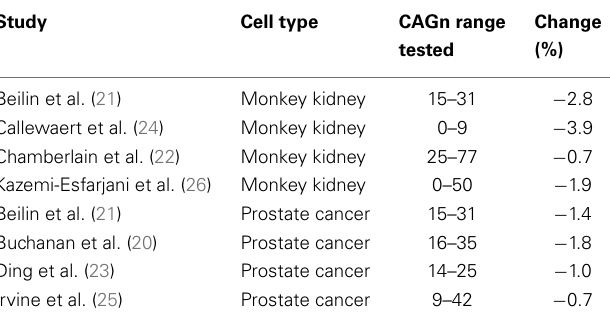
Table 1 | Change in androgen driven target gene activity per additional CAG repeat in theAR gene in in vitro studies